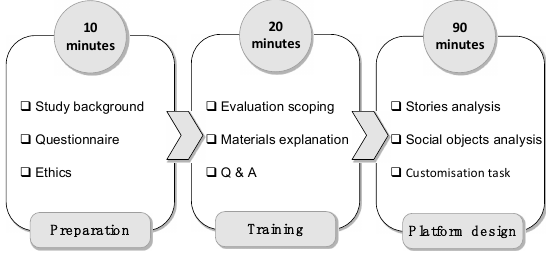
Figure 1. Case study first phase protocol.